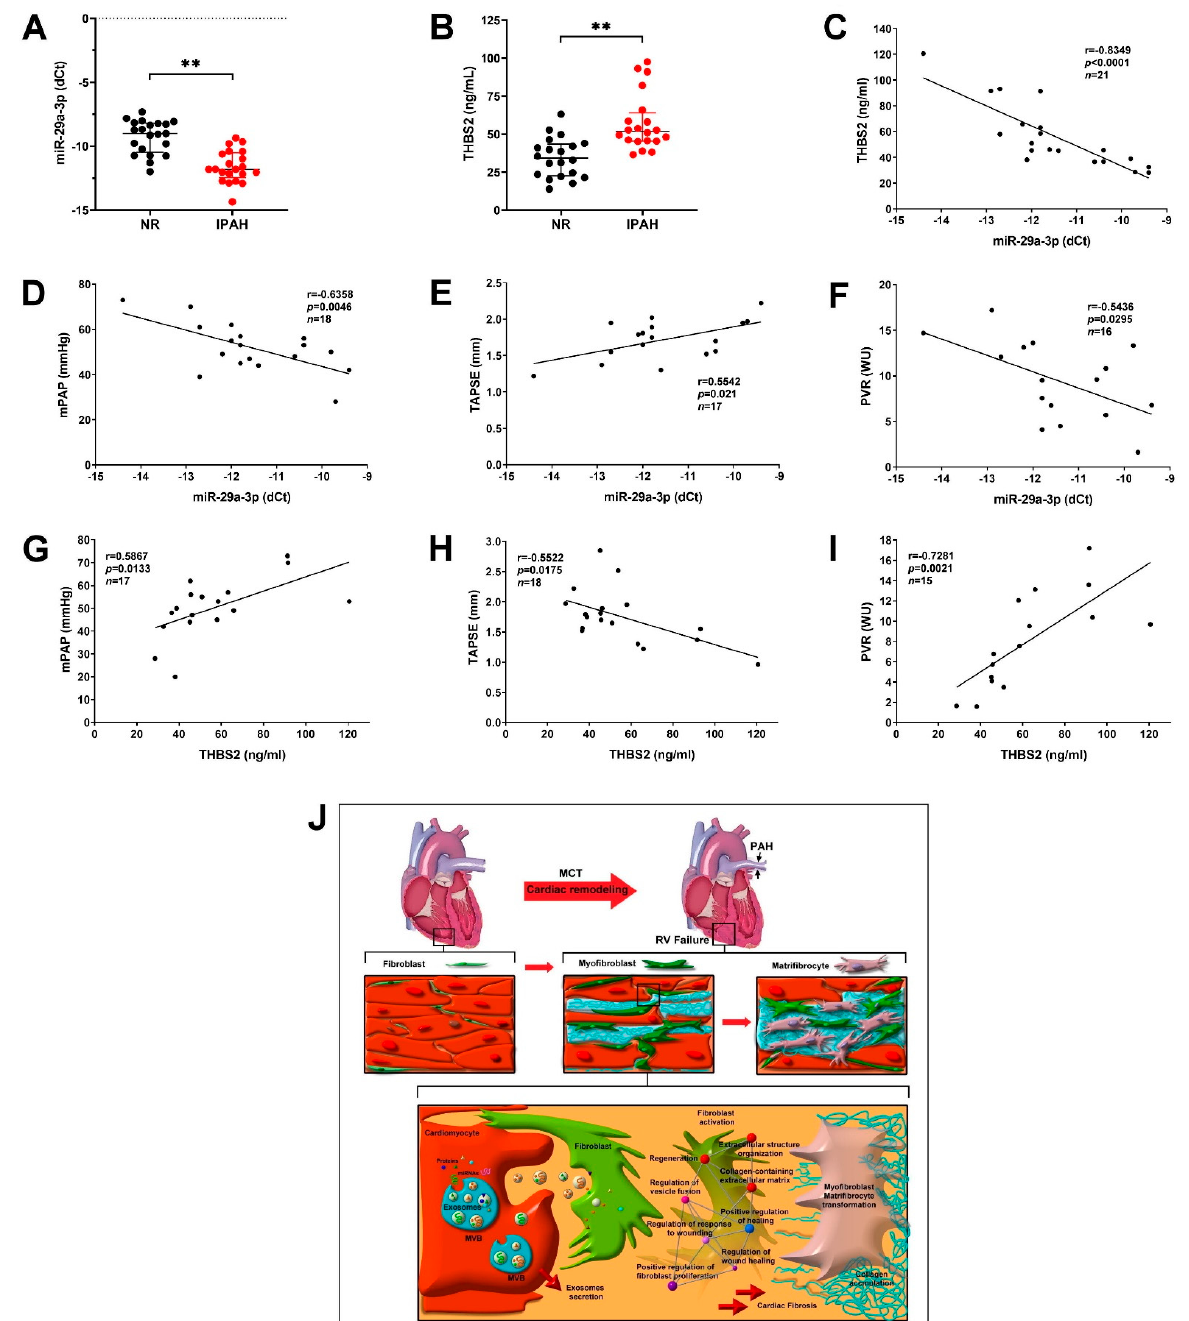
Figure 7. MiR-29a-3p/THBS2 axis regulates the progression of pulmonary artery hypertension (PAH). ( A ) Exosomal miR-29a-3p level in the serum of healthy controls (NR) and patients with PAH was determined by real-time PCR. ( B ) THBS2 expression in the serum was determined by ELISA. Data are expressed as median and interquartile range. Mann–Whitney U-test was used to compare two independent groups (** p < 0.01). ( C ) Correlation coefficient between the miR-29a-3p and THBS2 expression levels. R, Pearson’s correlation coefficient. ( D – F ) The correlation of miR-29a-3p with the mean pulmonary artery pressure (mPAP), tricuspid annular plane systolic excursion (TAPSE), and pulmonary vascular resistance (PVR) in patients with PAH. ( G – I ) The correlation of the serum THBS2 level with mPAP, TAPSE, and PVR in patients with PAH. ( J ) Suggested mechanism underlying PAH-induced cardiac fibrosis mediated by exosomal miR-29a-3p and THBS2. Serum miR-29a-3p and THBS2 (secreted by cardiomyocytes) might increase cardiomyocyte hypertrophy and promote cardiac fibroblast to myofibroblast transformation, enhance collagen production/deposition, and augment cardiac